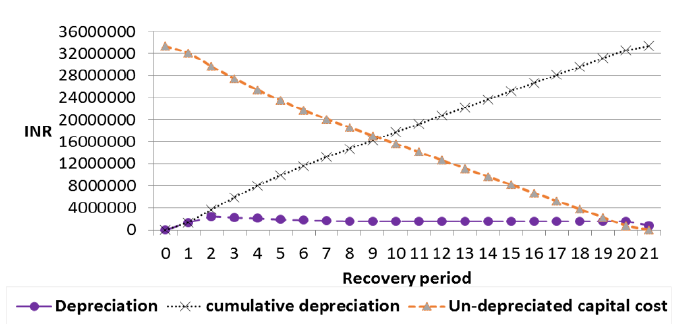
Figure 4. MACRS depreciation of diesel generator project.